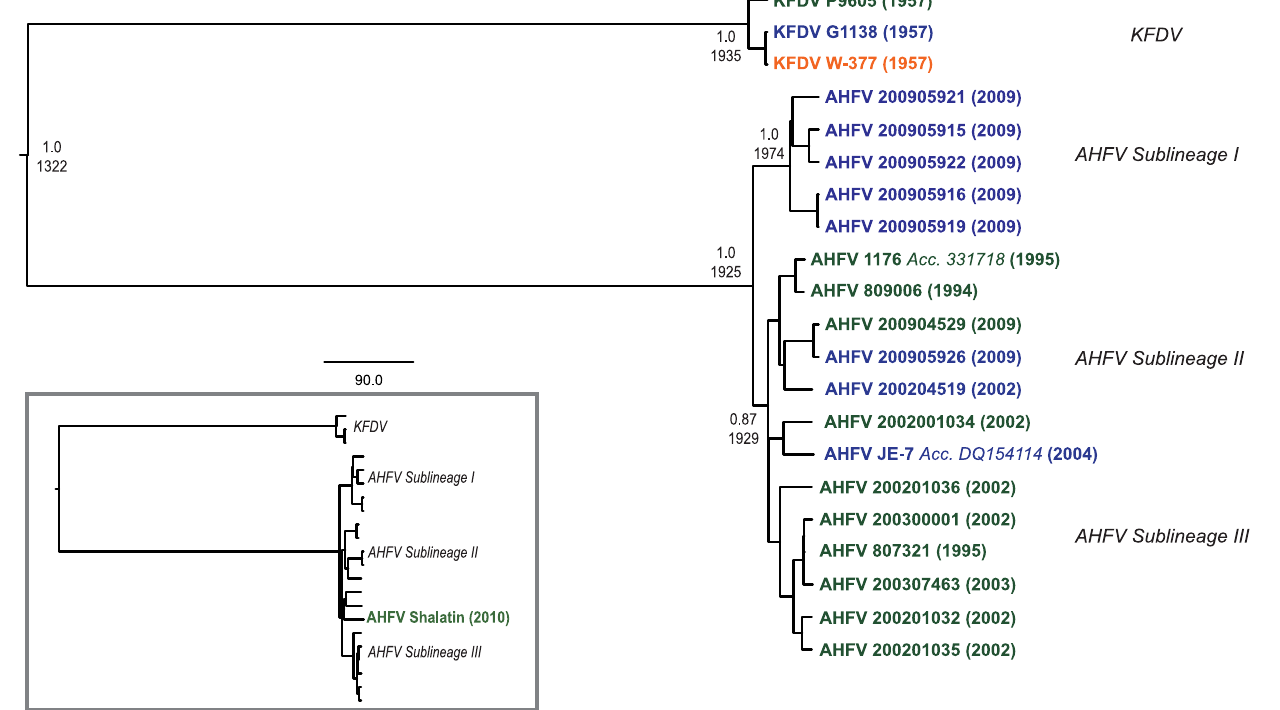
Figure 2. AHFV and KFDV full-length genome phylogeny. Phylogeny is based on Bayesian coalescent analysis of AHFV and KFDV full-length sequences. For selected clades, posterior probability values are listed above the TMRCA. Text color indicates host species: human isolates (green), tick pool isolates (blue), and nonhuman primate isolate (orange). The GenBank accession numbers are JF416949-67. Inset: Full-genome phylogeny with inclusion of short sequence fragments from 2010 Egyptian isolate (Shalatin, GenBank Acc. # HM629507, HM629508) shown in green.